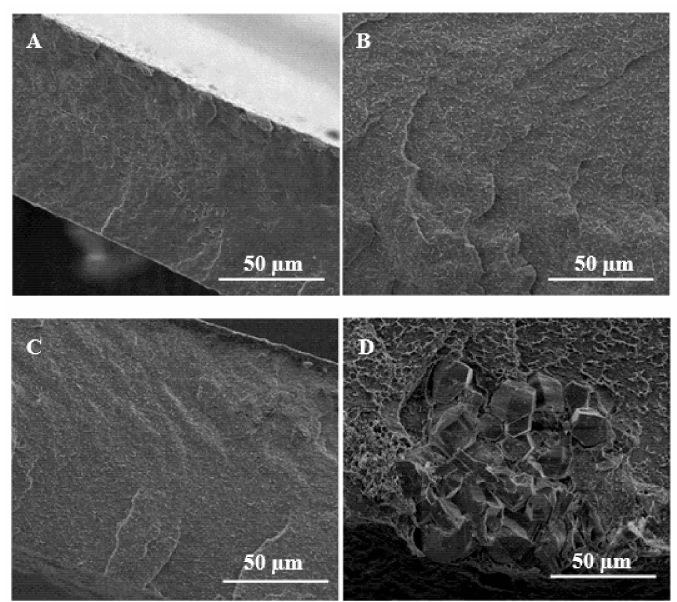
Figure 5. SEM micrograph of fracture surface of the samples in films forms: neat PHBV ( A ),